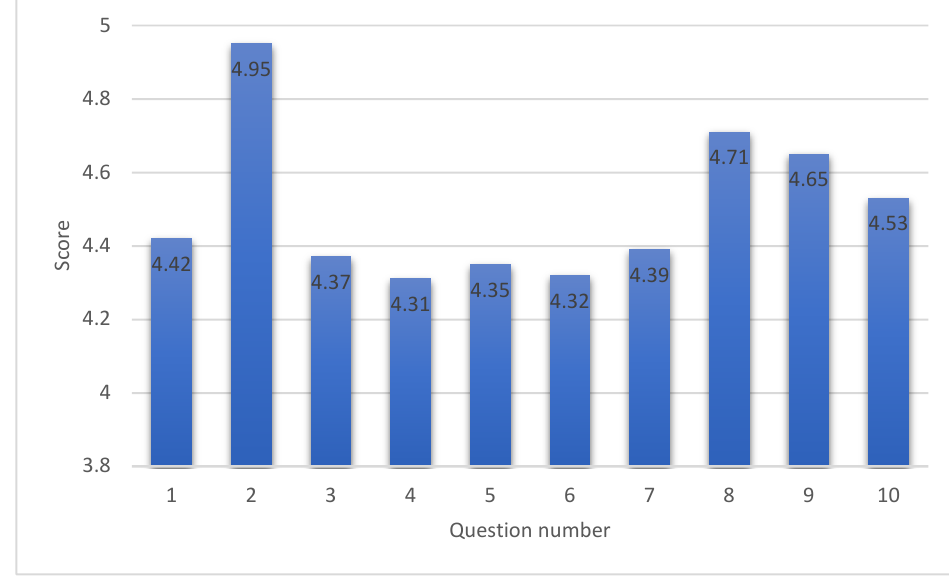
Figure 22. SUS questionnaire.